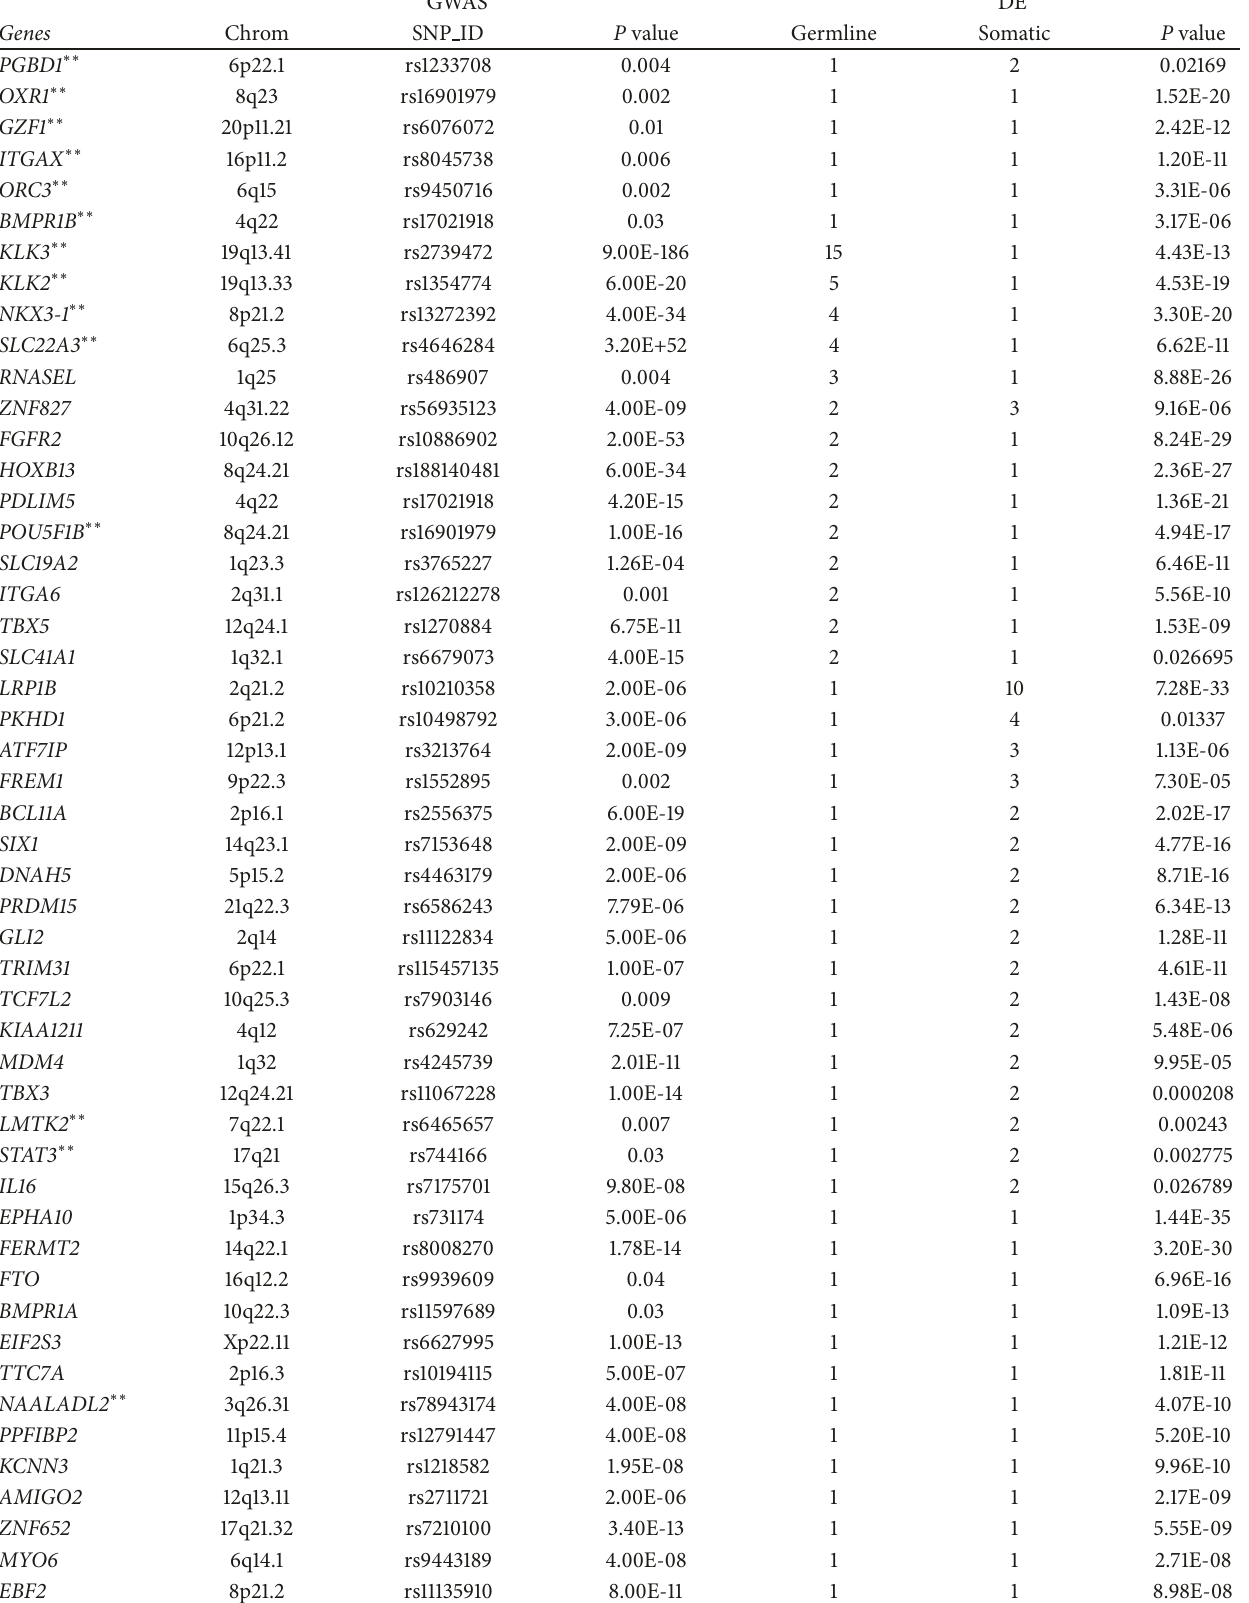
Table 2: List of the 61-gene signature containing both germline and somatic mutations found to be significantly differentially expressed between aggressive tumors and controls. ∗∗ indicates the gene containing genetic variants directly associated with aggressive